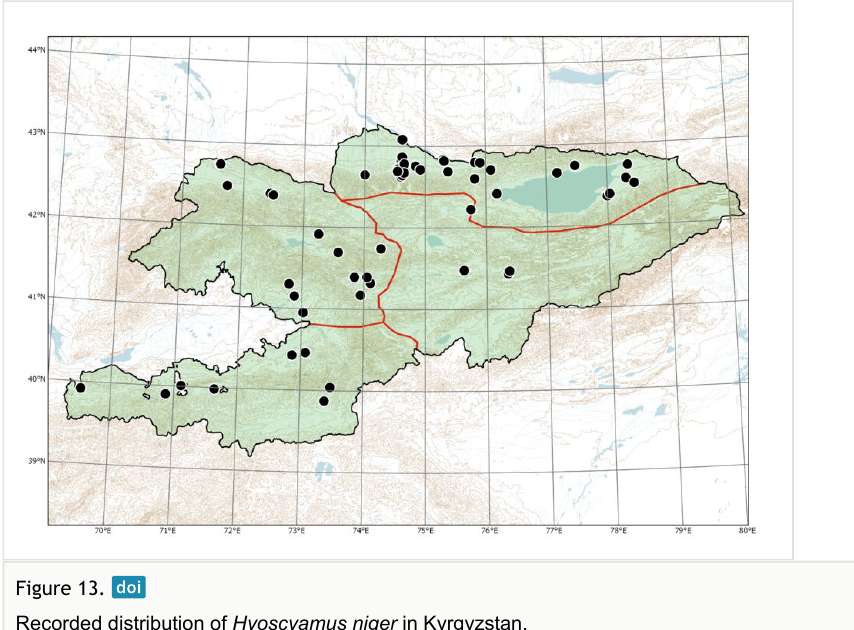
Figure 13. Recorded distribution of Hyoscyamus niger in